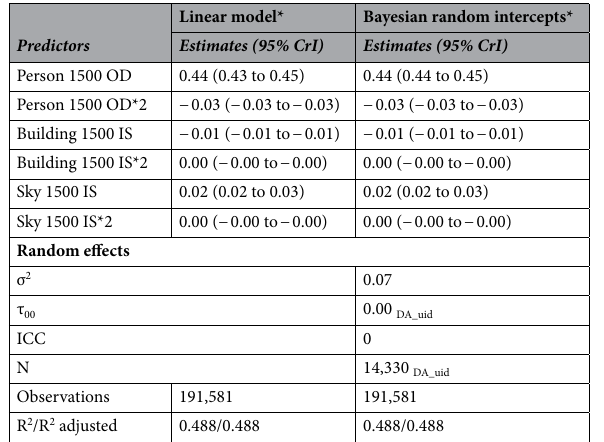
Table 2. Associations between individual GSV features and log-transformed walk-to-work rates, all cities combined. *Models included a fixed effect for each city. OD object detection, IS image segmentation, and CrI credible interval.